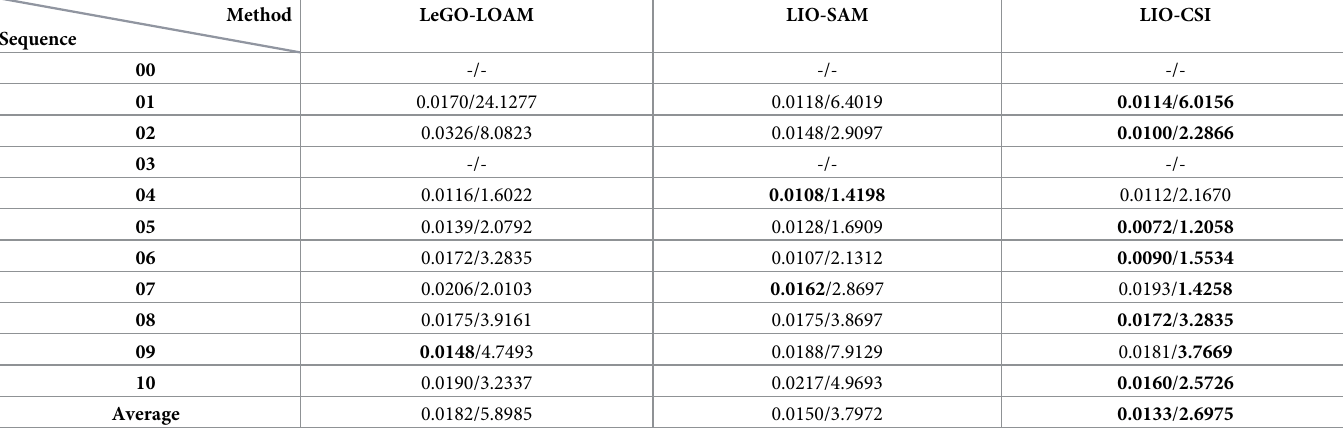
Table 3. Relative pose error on KITTI